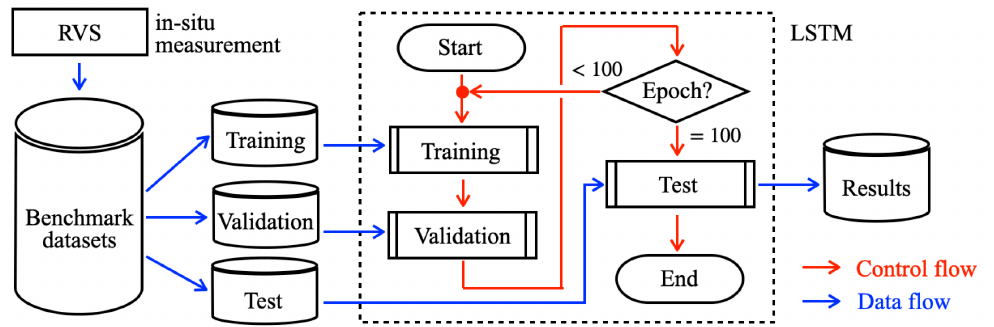
Figure 17. Flowchart of our proposed prediction method using LSTM.